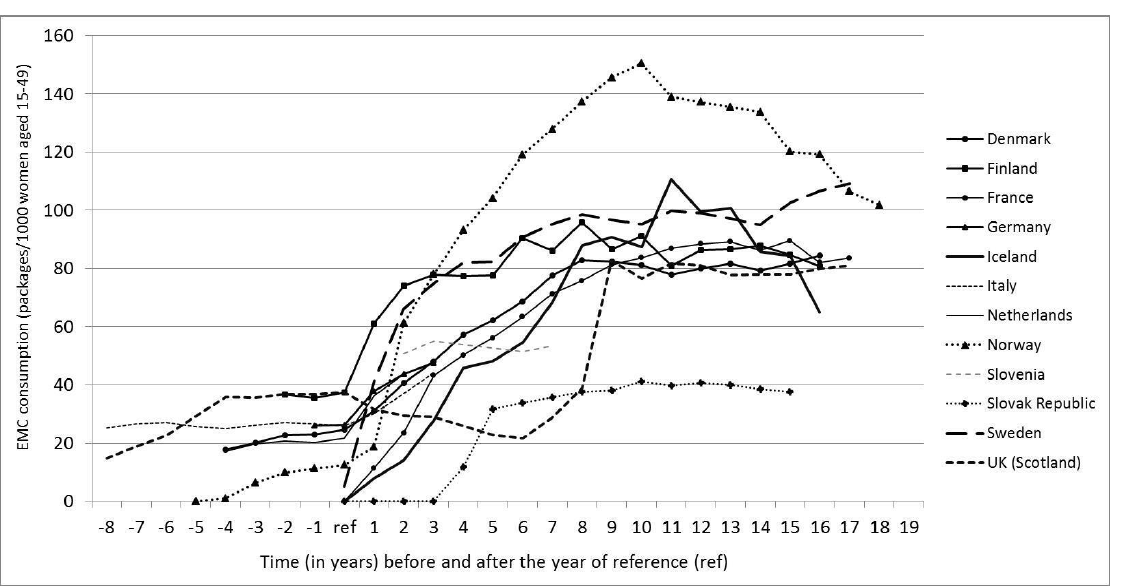
Figure 3. EMC consumption over time (figures include ATC codes G03AD01, G03AD02 and